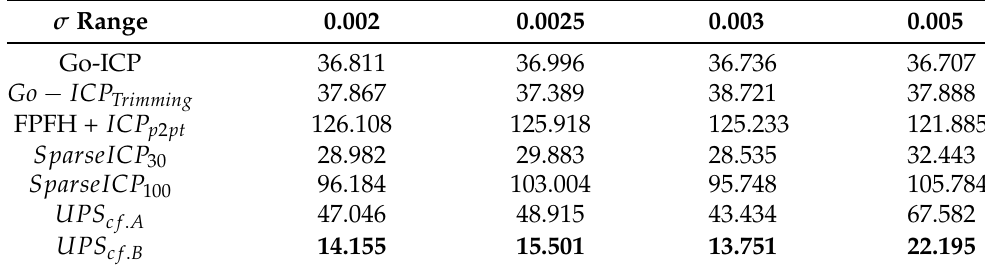
Table 7. Running times of registration methods for noise-influence study. σ